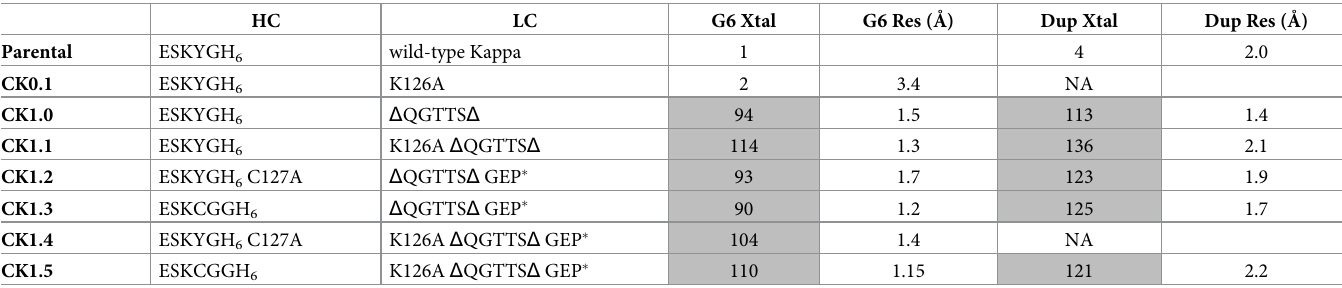
The parental light chain was the wild-type kappa. The parental heavy chain terminated at the sequence ESKYG and included six histidines for purification purposes. The ‘Xtal’ column indicates how many conditions from two 96-well screens produced any kind of crystal by approximately day 9. Several crystals were sent for data collection from each construct with harvestable crystals and the best resolution dataset is